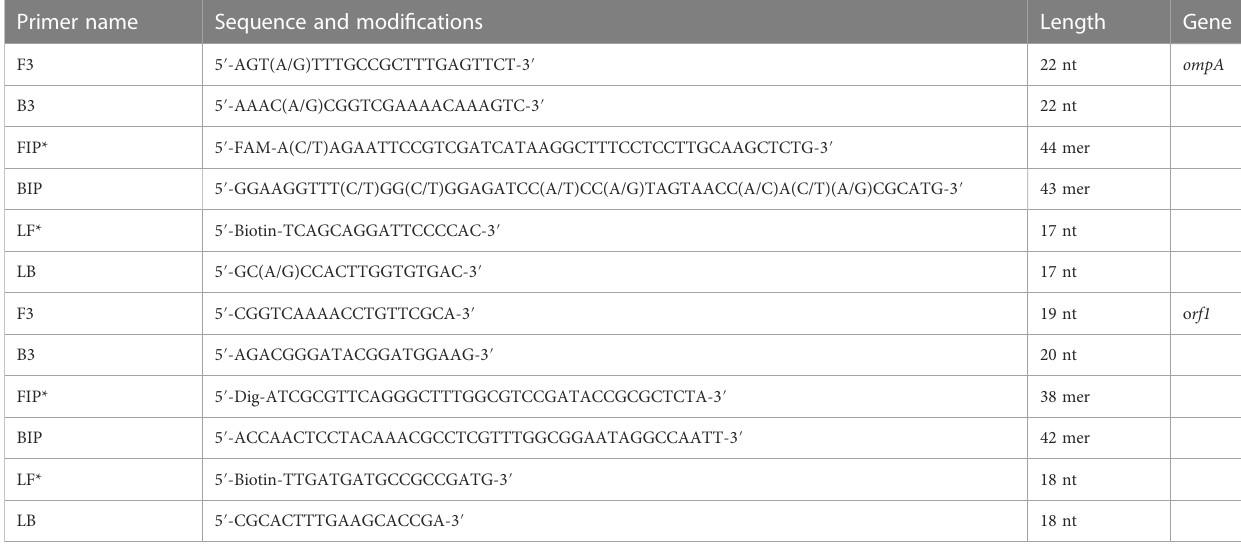
TABLE 2 The mLAMP-AuNPs-LFB primers used in this